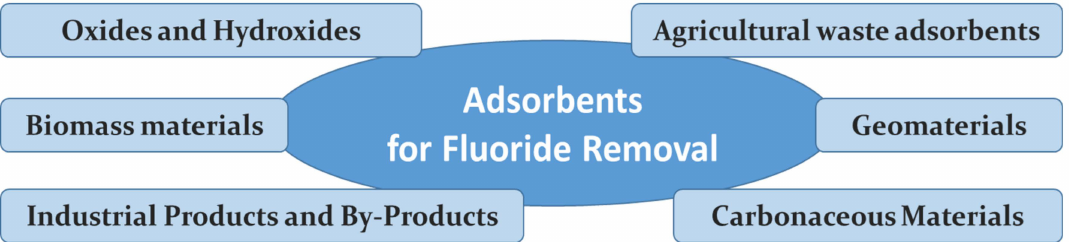
Figure 1. Selected types of industrial waste that are used as fluoride